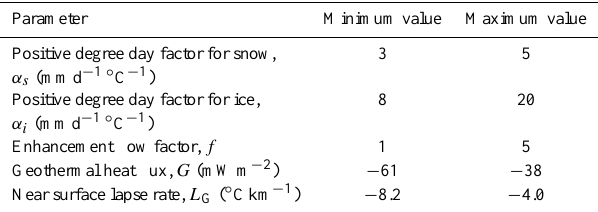
Table 4. List of five parameters varied according to the ranges de- termined from the literature. The parameters α i , α s , G and f are similar to those used in Ritz et al.